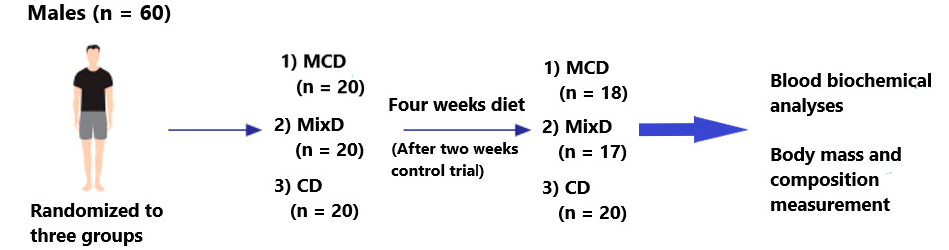
Figure 1. Scheme of the descriptive analysis. MCD — low-energy moderate-carbohydrate diet; MixD — low-energy mixed diet; CD — conventional diet.